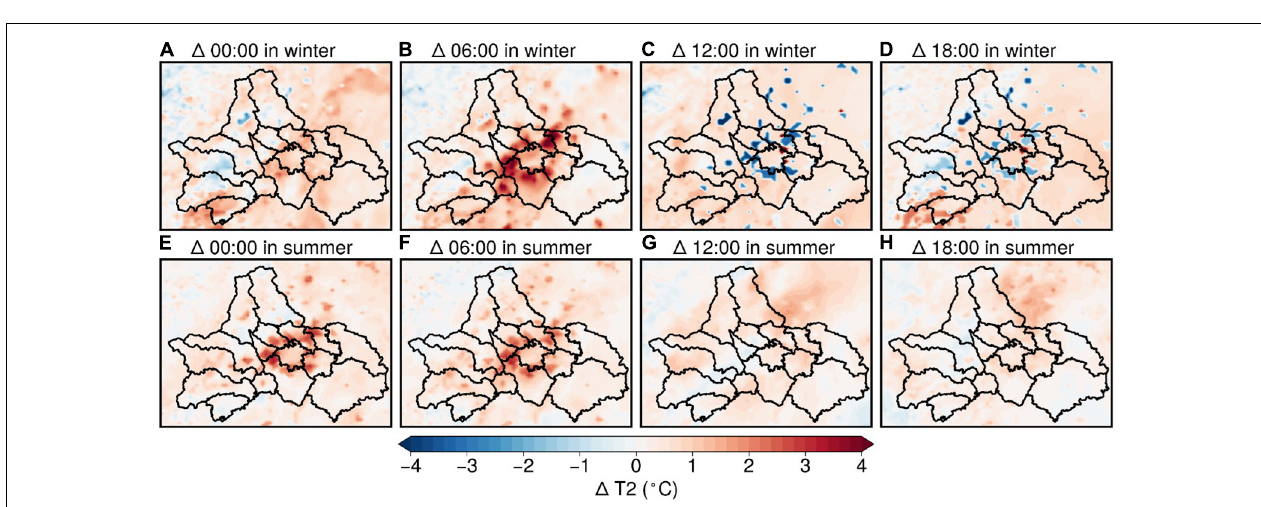
FIGURE 4 | Time series of simulated and observed hourly concentrations of O 3 at the (A) JQLH, (B) SLD, and (C) SWY stations over 10-16 July, 2017 and time series of simulated and observed hourly concentrations of PM 2 . 5 at the (D) JQLH, (E) SLD, and (F) SWY stations over 25–31 December, 2017.